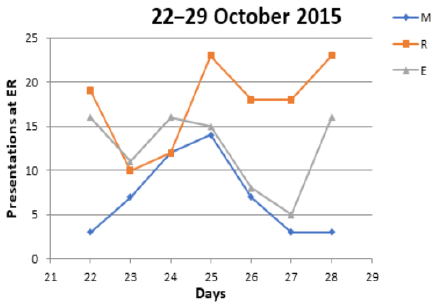
Figure 7. Emergency room presentations at three Israeli hospitals in the 3 days preceding and following the 25 October 2015 super- cell event: Meir Medical Center (blue), Rambam Medical Center (orange) and Ha’Emek Medical Center (grey).